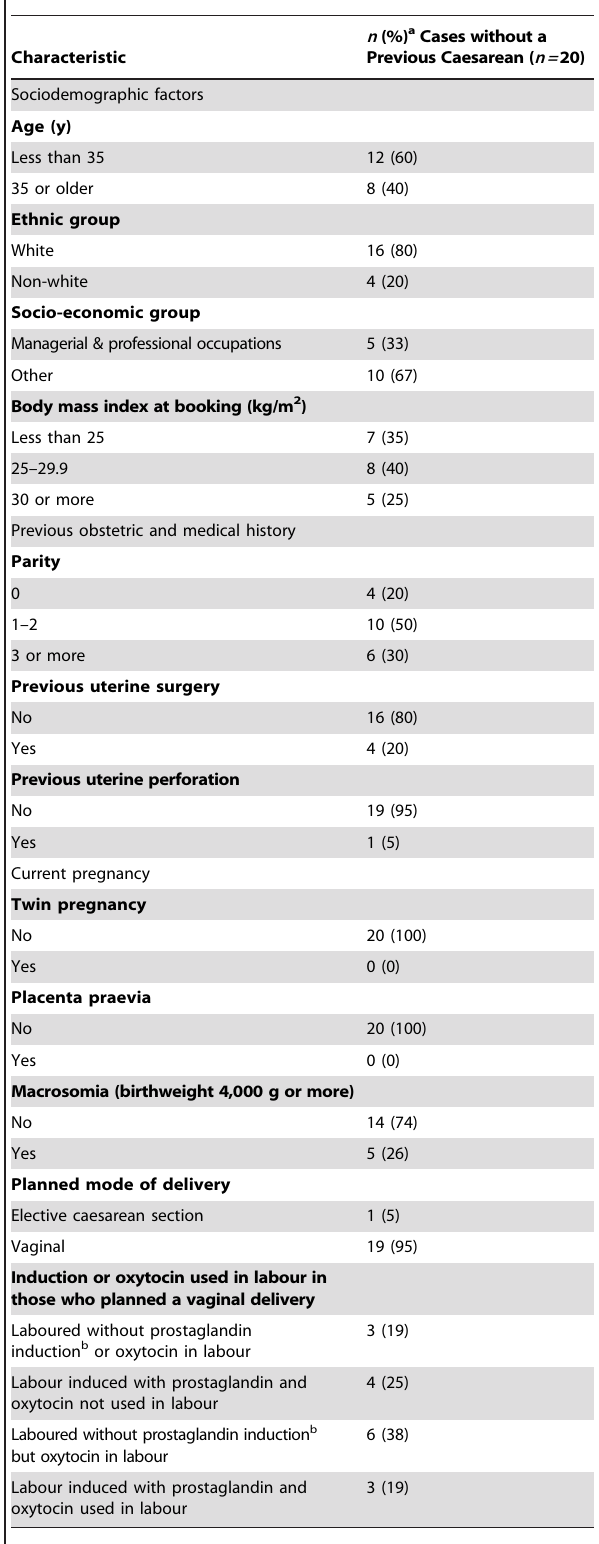
Table 6. Characteristics of women who had a uterine rupture in the absence of a prior delivery by caesarean